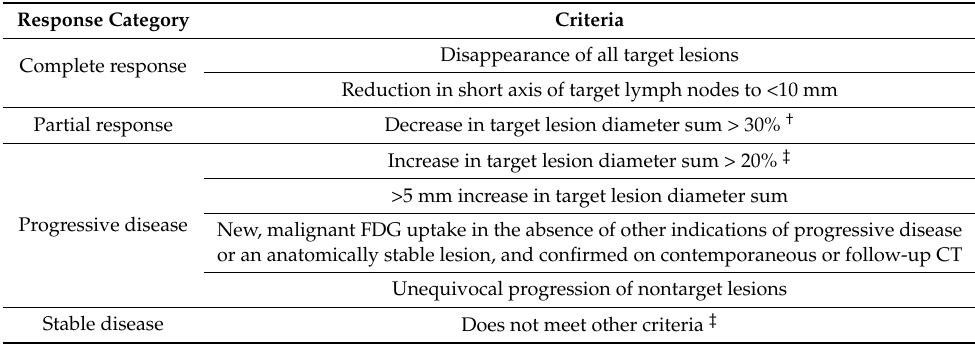
Table 3. Comparison between RECIST 1.1 and PERCIST Response Evaluation Criteria in Solid Tumors (RECIST 1.1)